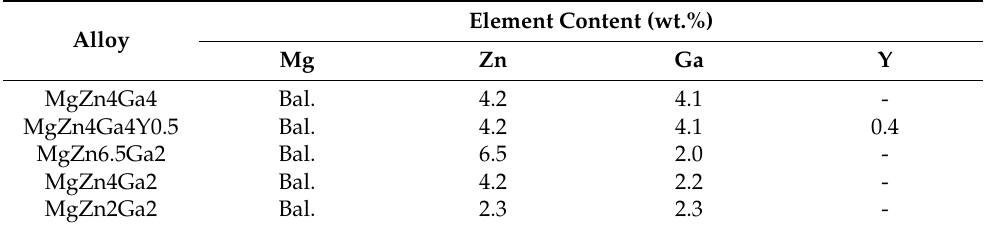
Table 1. Chemical compositions of the prepared alloys.